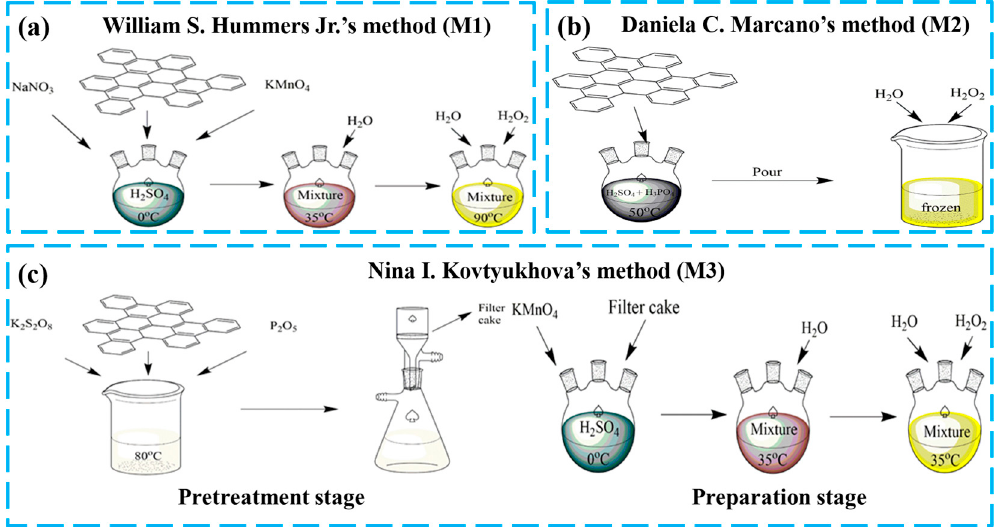
Figure 1. Schematic diagram of the preparation process of three types of GOs ( a ) WIilliam S. Hummers Jr.’s method, ( b ) Daniela C. Marcano’s method and ( c ) Nina I. Kovtyukhova’s method.